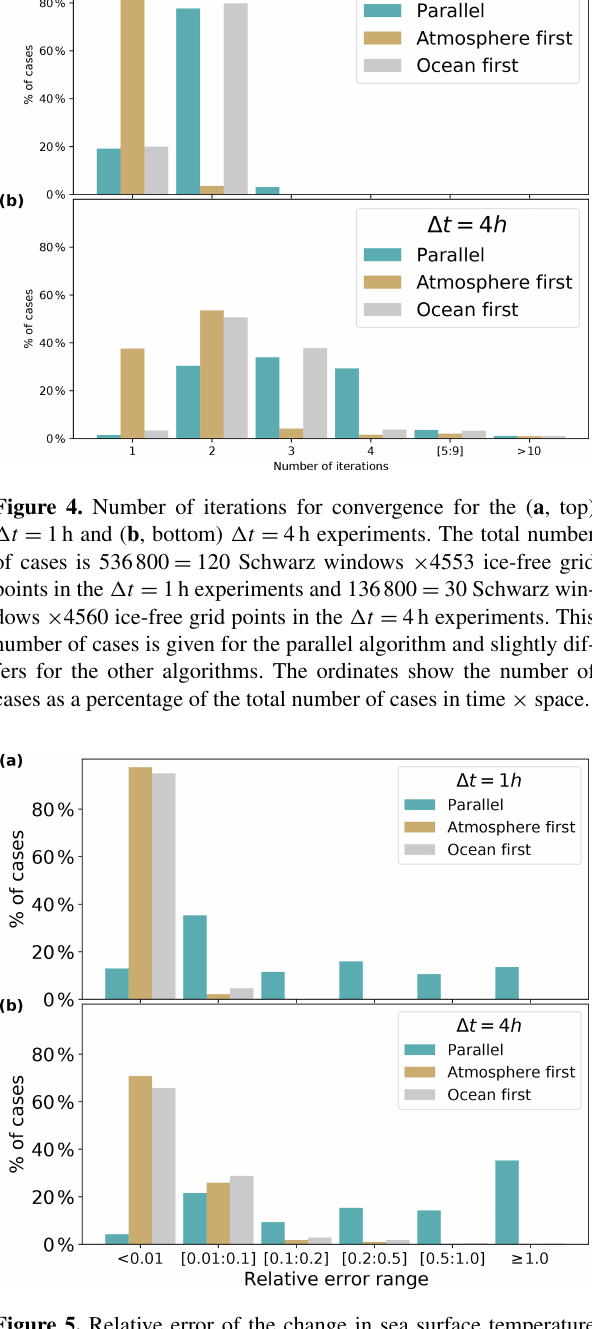
Figure 5. Relative error of the change in sea surface temperature during a Schwarz window. The error is computed as the ratio be- tween (i) the correction due to the iterative procedure (the jump from green dots to the converged solution in grey in Fig. 3) and (ii) the solution change between t and t + (cid:49)t with no Schwarz iter- ation (the jump from yellow to green dots in Fig. 3). See the legend in Fig. 4 for the explanation of the ordinate